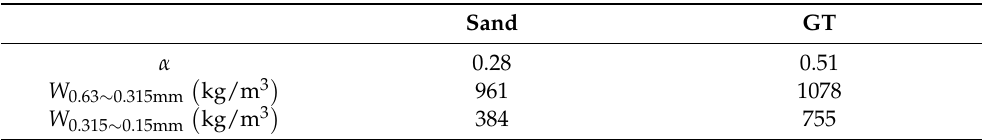
Table 7. Optimal gradation of sand and GT.